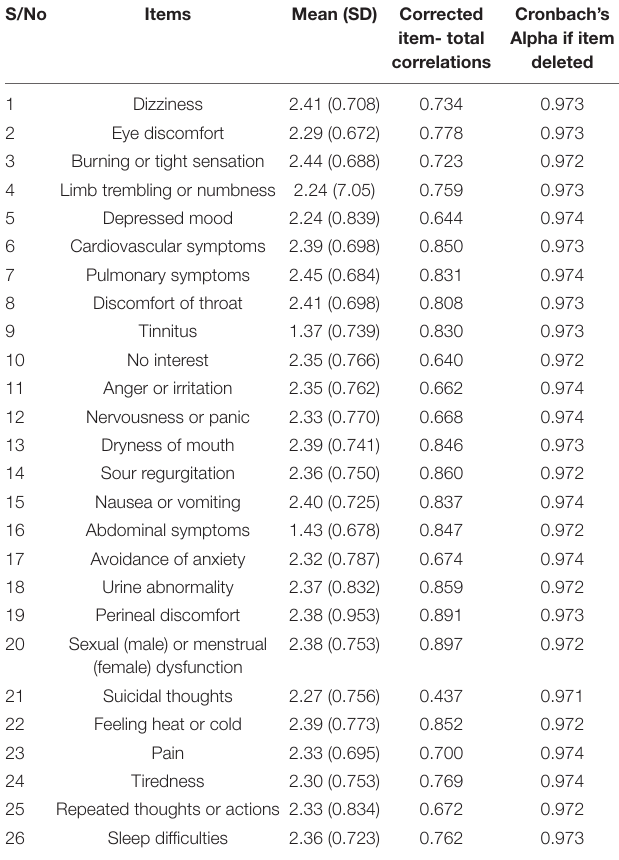
TABLE 3 | Internal consistency of Psychosomatic Symptoms Scale (PSSS) Urdu version.